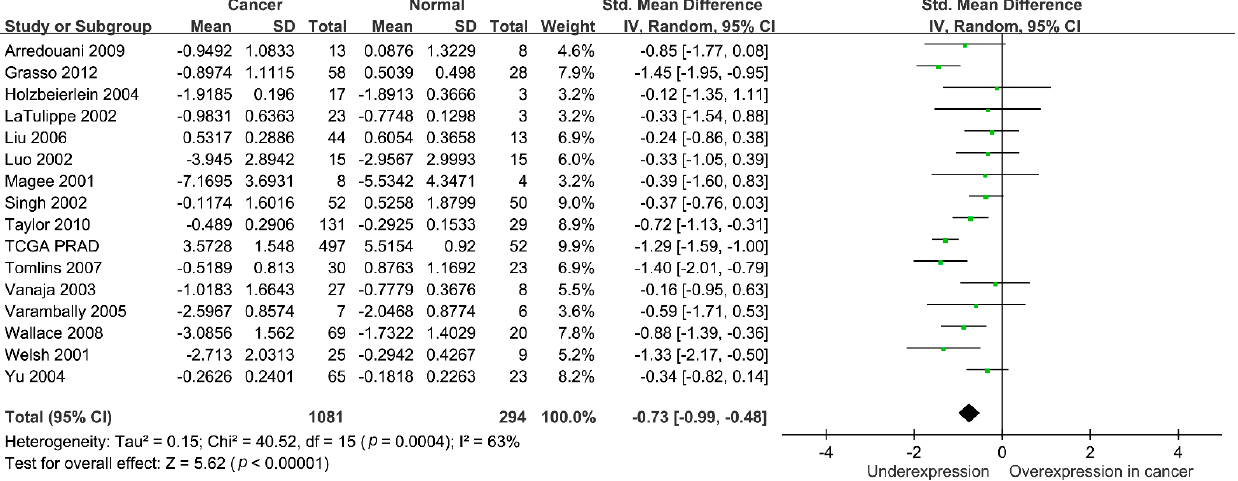
Figure 5. Meta-analysis of NRG1 expression levels between tumor and normal tissues in 16 independent prostate cancer studies. NRG1 showed lower expression in prostate cancer than in normal tissues. SD, standard deviation. IV, inverse variance. CI, confidence interval. Std, standardized.